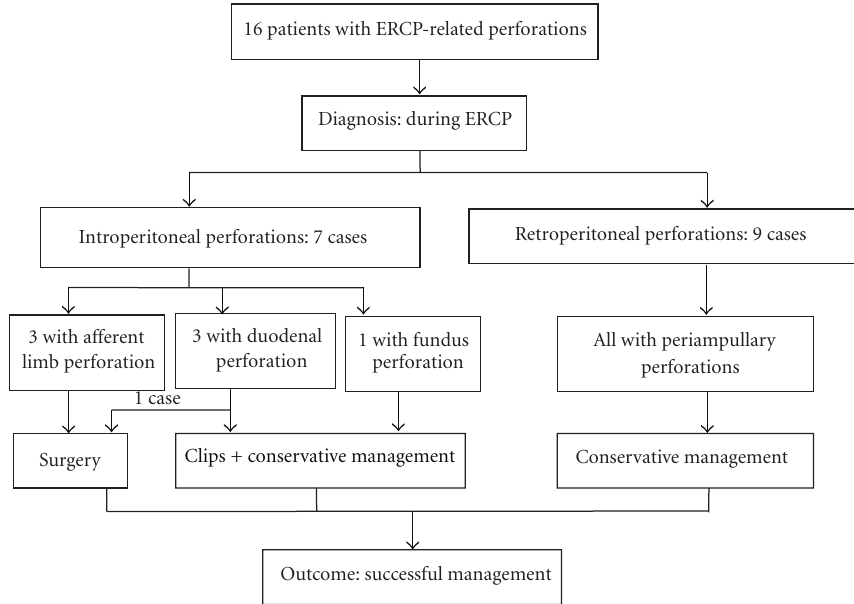
Figure 1: The management and outcome of 16 patients with ERCP-related perforation.